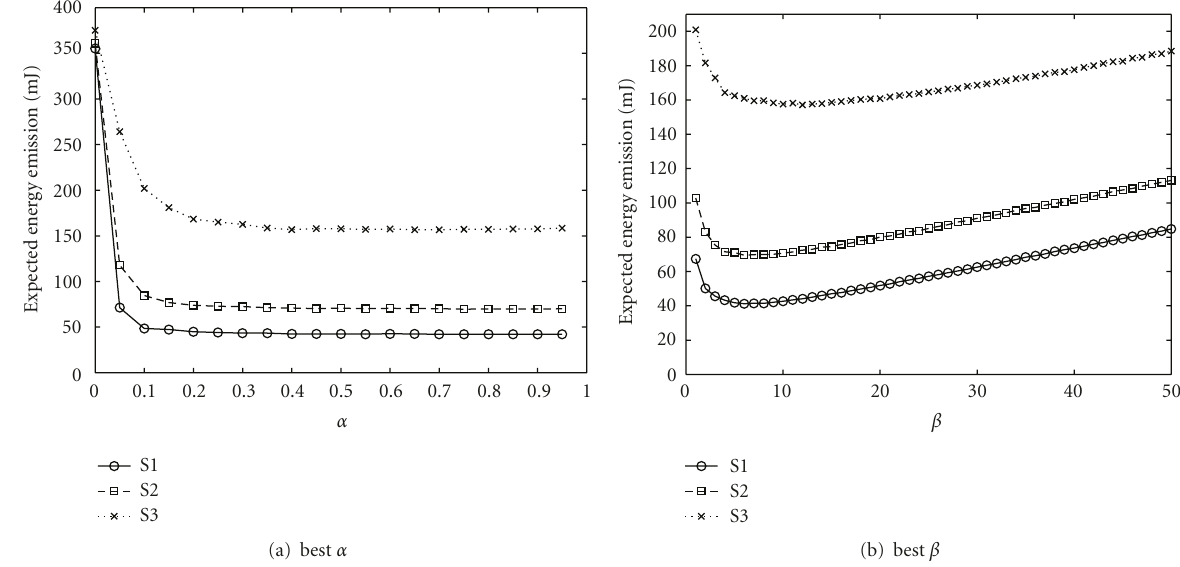
Figure 6: The best α and β for IEEE 802.11, 2Mbps.